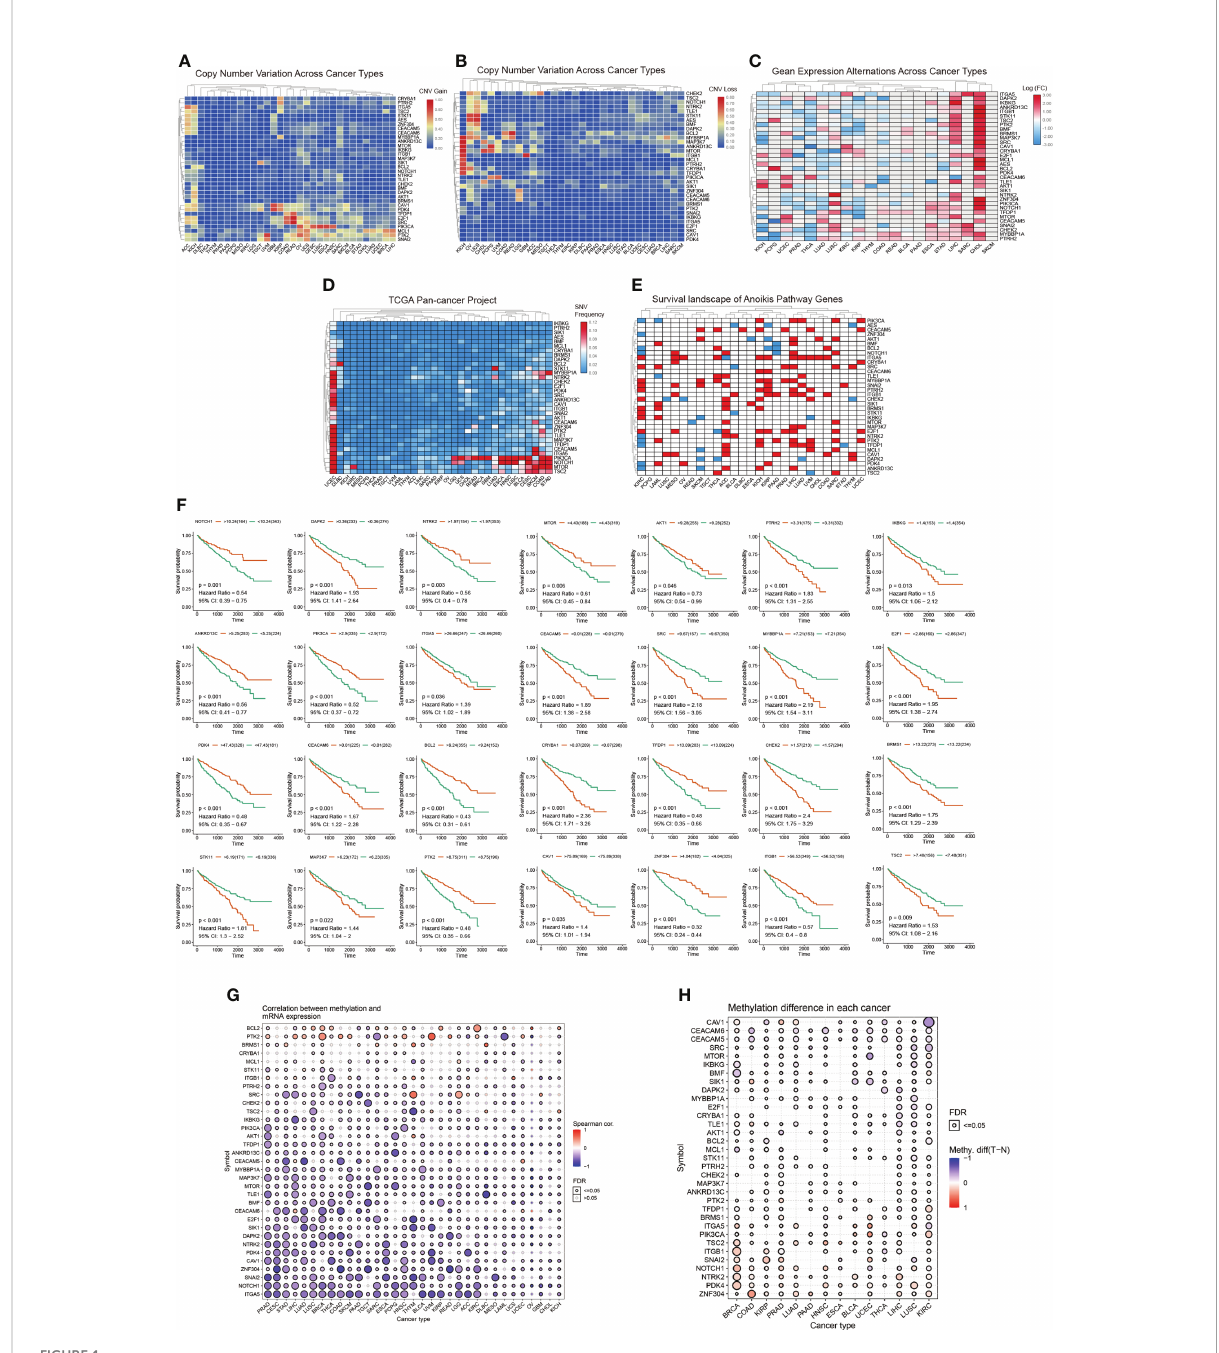
FIGURE 1 (A, B) CNV frequencies of the 34 anoikis pathway genes in the 32 tumor types. Red and blue colors indicate a CNV gain and loss, respectively. (C) Expression levels of anoikis-related genes in 20 cancers. The color code bars show the corresponding values of log2(FC) on the right, with the shift from red to blue corresponding to values ranging from 3.00 to -3.00. (D) SNV frequencies of the 34 anoikis pathway genes in the 32 tumor types. Red and blue colors indicate a high and low frequency, respectively. (E) The three categories of anoikis-related genes: risk genes (Red), protective genes (Blue), and no statistically signi fi cant genes (White, p > 0.05). (F) Survival curve analysis of all statistically signi fi cant genes in KIRC in TCGA samples. Red and blue colors represent high and low expression groups, respectively. (G, H) Different degrees of methylation in each cancer and correlation between methylation and mRNA expression levels. The color depth of the ring on the right indicates the comparison between the P-value and 0.05. The color bar indicates the degree of difference and the correlation coef fi